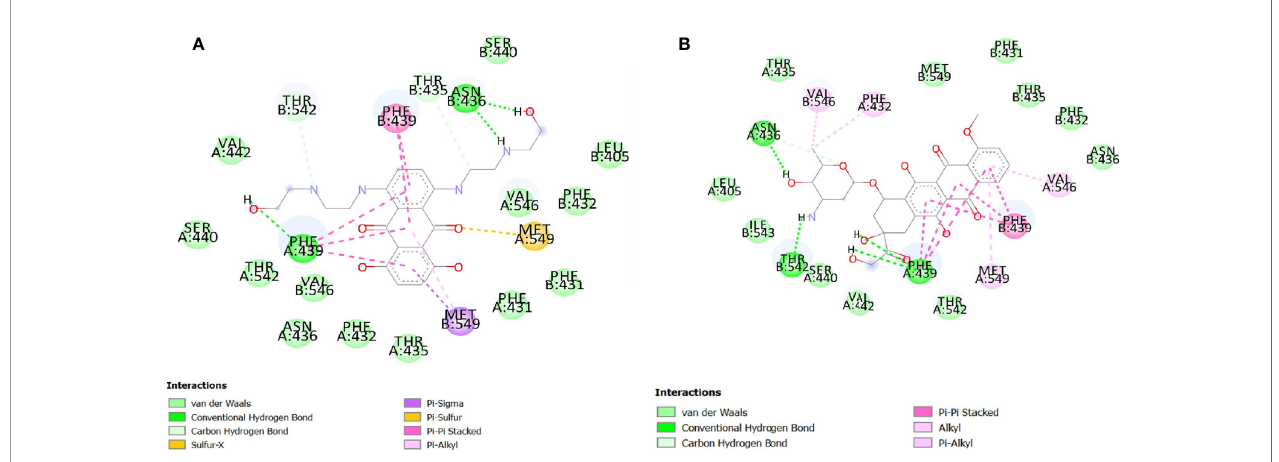
FIGURE 2 | Two-dimensional (2D) representation of the interactions of mitoxantrone (A) and doxorubicin (B) with ABCG2, generated by discovery studio visualizer v16.1.0. The different residues are marked by colored circles and three-letter abbreviations, and the colors indicate the type of